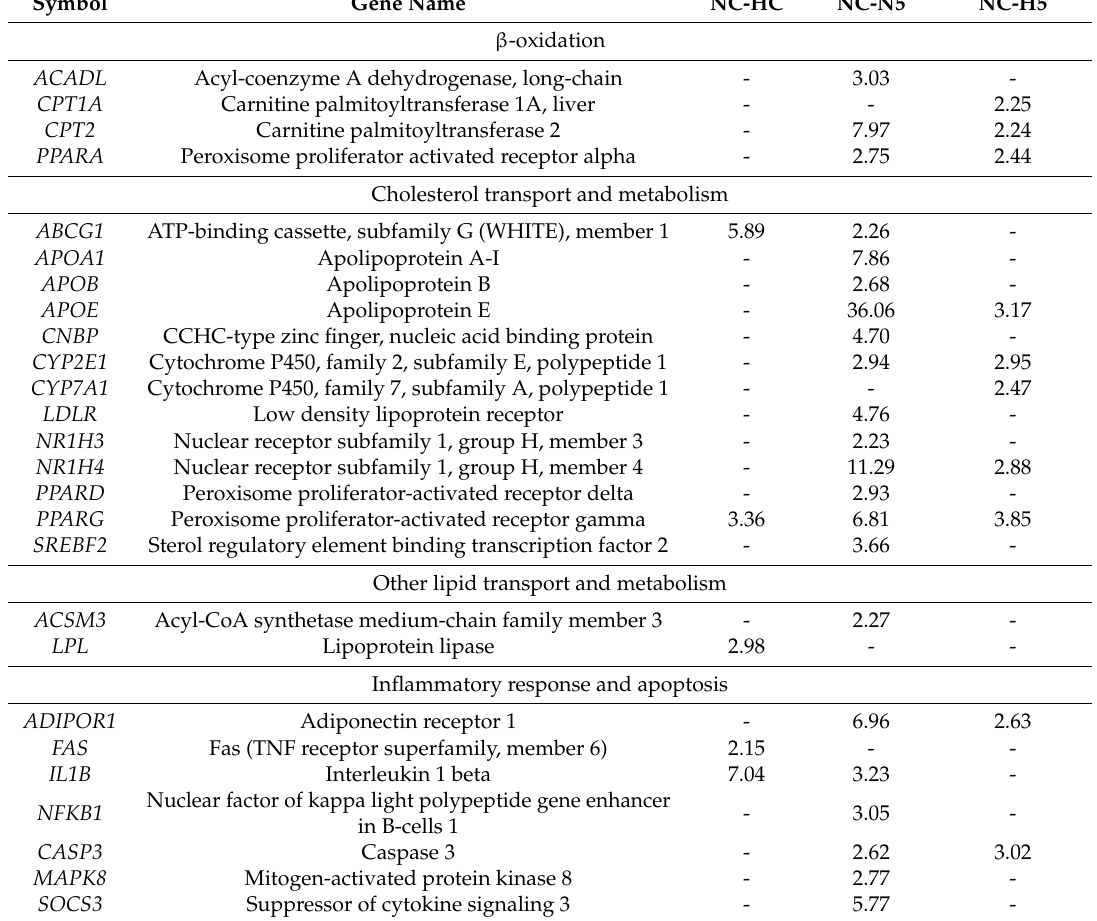
Table 6. Gene symbol, gene name, and relative fold change of the genes that showed an over or down-expression value higher than 2 ( p < 0.05) in the rat livers 1